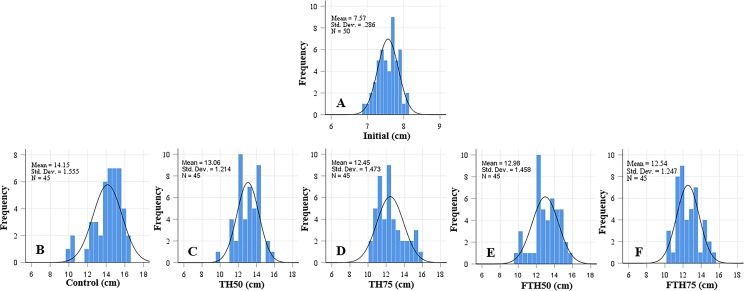
Length frequency distribution of initial fish (A) and fish fed on TH diets (B–F) without or with fermentation after 56 days.Frequency histograms of fish from different groups where control, TH50 and FTH50 fish showing negatively skewed curve indicate a higher proportion of large-body species, and the remaining groups of TH75 and FTH75 skewed positively indicate small-body species within the normal distribution. n = 50 for initial fish (A), n = 45 for each experimental treatment (B–F).